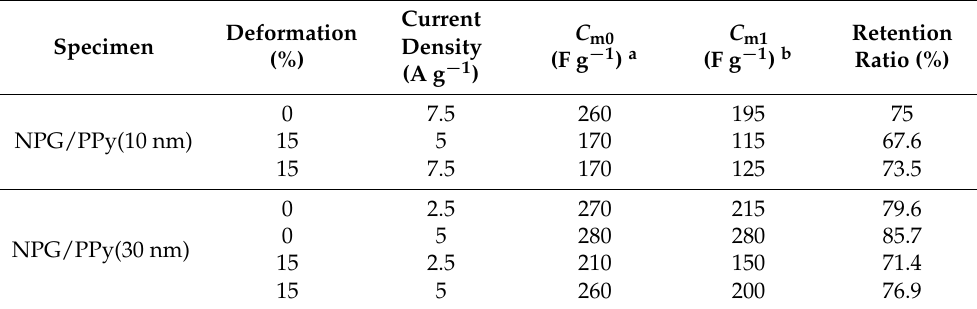
Table 1. Specific capacitance, C m , of NPG/PPy hybrid materials at the beginning and end of GCD cycling under various deformations and current densities. The data in the table are in agreement with the data points shown in Figure